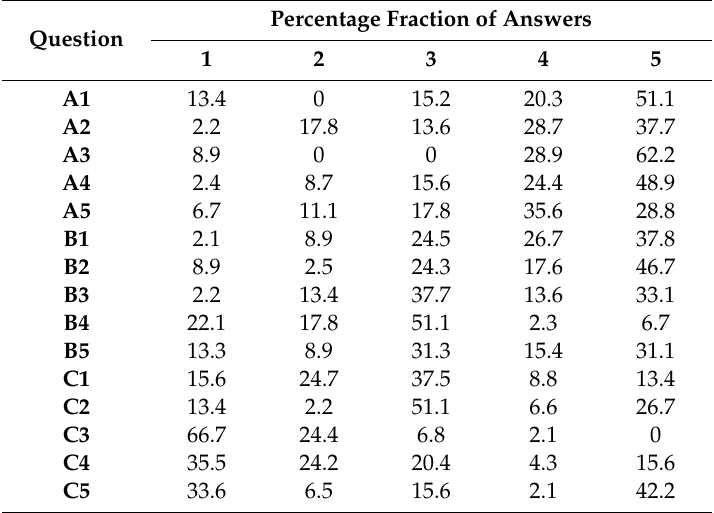
Table 7. Percentages of answers to particular questions (own